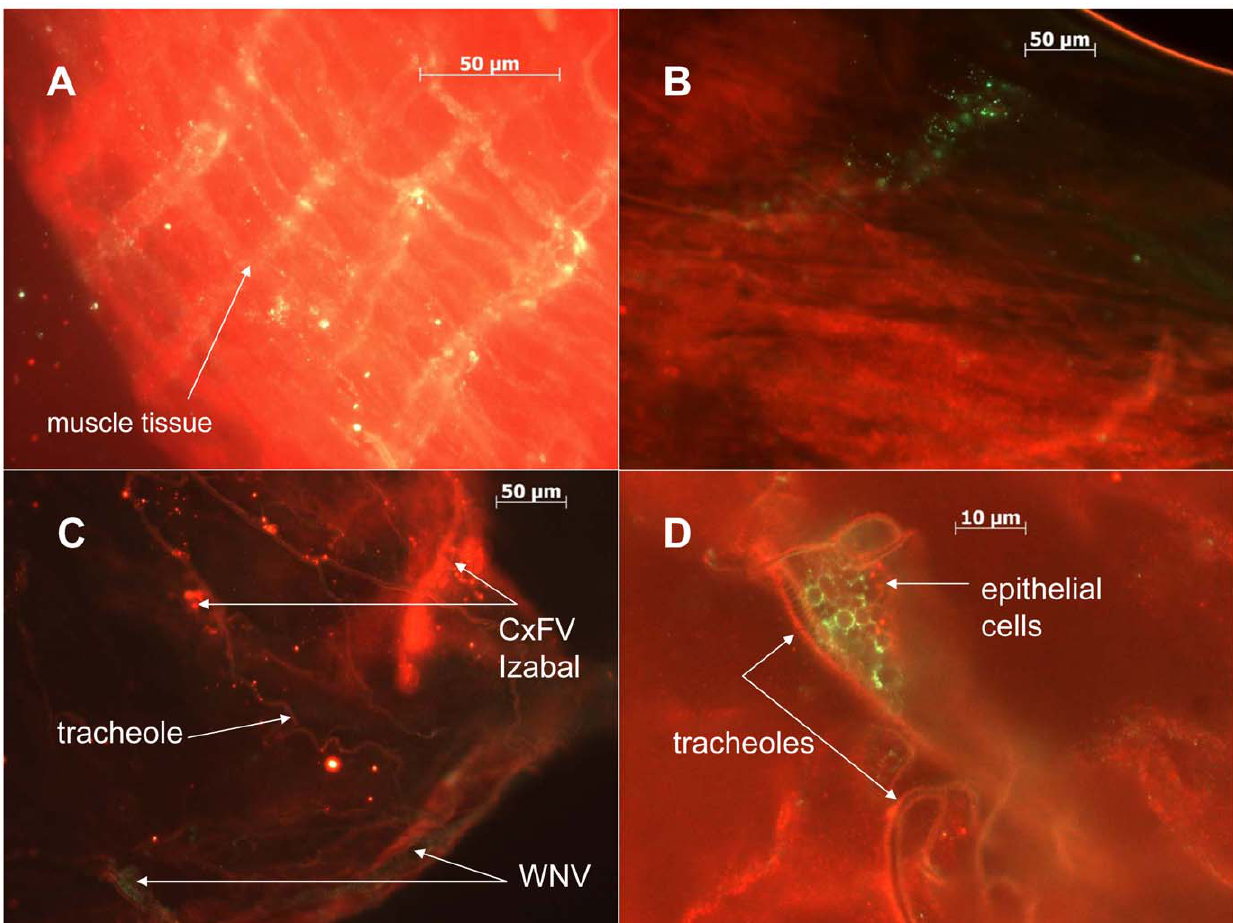
Figure 7. Localization of CxFV Izabal and WNV to the midgut in co-infected mosquitoes. A) WNV-infected muscle tissue of Cx. quinquefasciatus Sebring, harvested 9 DPI. WNV stained with AlexaFluor 488 (green). B) Focus of CxFV Izabal infection on the midgut of Cx. quinquefasciatus . CxFV Izabal stained with AlexaFluor 488. C) Midgut of Cx. quinquefasciatus infected simultaneously with both WNV and CxFV Izabal by intrathoracic inoculation. CxFV Izabal stained with AlexaFluor 594 (red) and WNV with AlexaFluor 488 (green). D) Close-up view of co-infected midgut from panel C showing midgut epithelial cells infected with WNV and CxFV Izabal. CxFV Izabal stained with AlexaFluor 594 (red) and WNV with Alexa 488